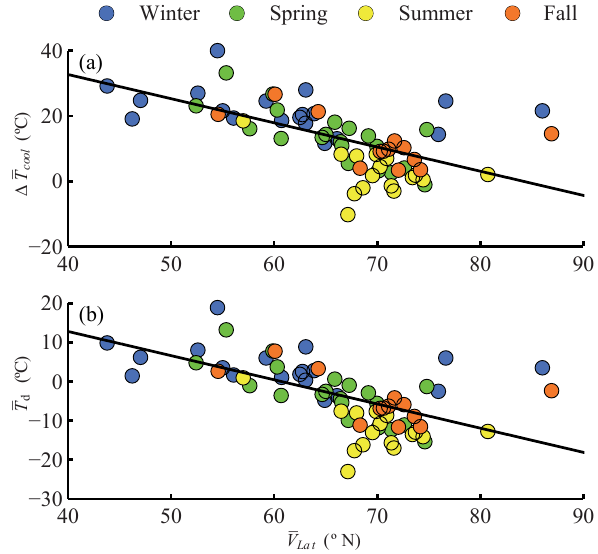
Figure 2. (a) Covarying behavior of mean vapor source region lat- itude, V Lat , and mean air parcel cooling during transport, (cid:49)T cool . (b) Covariation of the mean vapor source region latitude, V Lat , and dew point, T d . Both (cid:49)T cool and T d influence the δ 2 H of precipita- tion at Barrow, AK. Lines are best fits; scatter from them is due, in part, to seasonal variation in latitudinal temperature gradients and vapor source